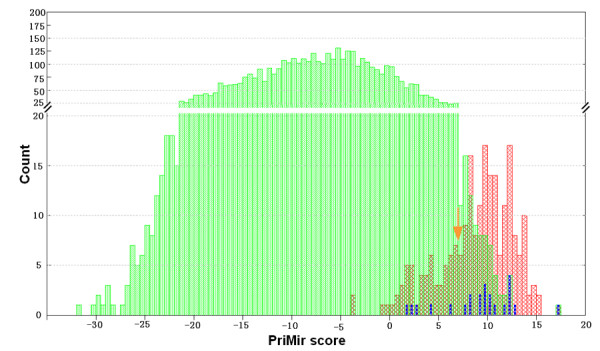
The distribution of PriMir scores of the training set and the potential pre-miRNA candidates. Red columns: the 220 known pre-miRNAs in the training set; blue columns: the 23 known pre-miRNAs in ml-ncRNAs; green columns: the predicted 4463 conserved hairpins. The red arrow indicates the cutoff value "7" PirMir used to predict candidate pre-miRNAs. Hundred and sixty-one (73%) of the 220 known pre-miRNAs fall above this cutoff. Of the 23 known pre-miRNAs located in ml-ncRNAs, 18 (78%) have scores higher than 7.